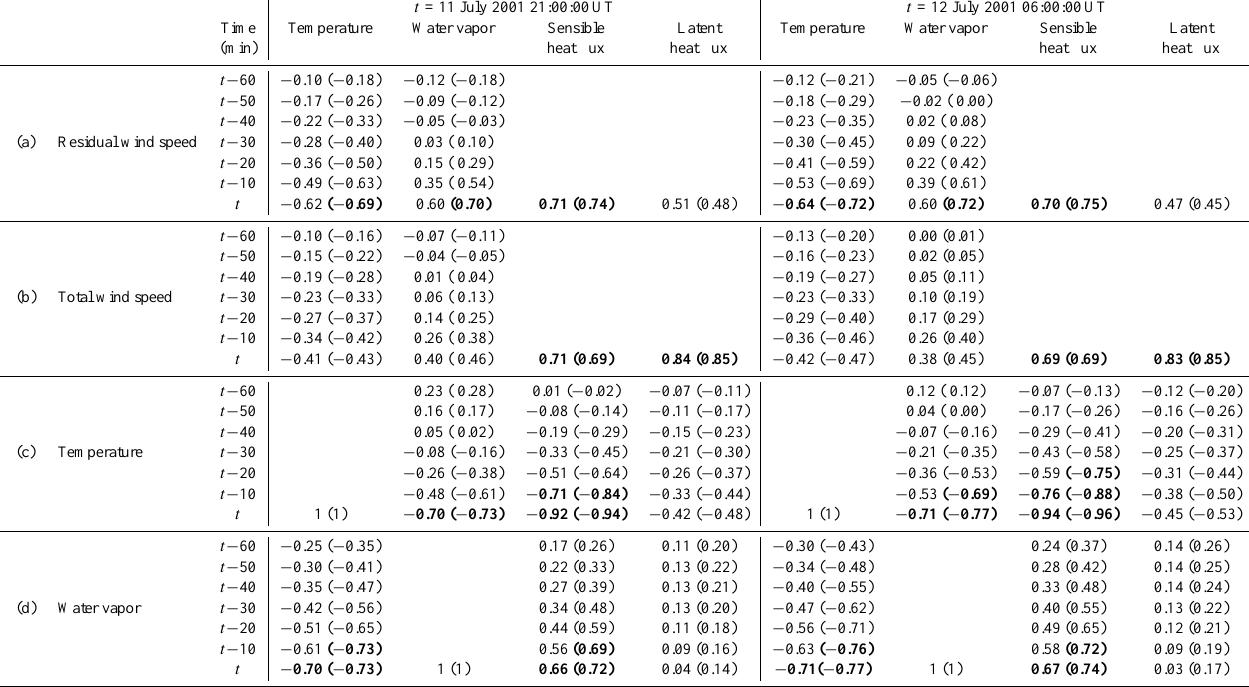
Table 2. Lagged spatial correlation coefficients of surface quantities in simulation S ◦ . Correlation coefficients with an absolute value ≥ 0 . 66 are highlighted in bold. Correlation coefficients in parentheses were calculated from data after filtering with a circular low-pass filter with a diameter of 4500m. Autocorrelation coefficients for lags < 0 were not calculated. Correlation coefficients between the surface heat fluxes and surface wind speeds were not computed for lags < 0, because surface heat fluxes are calculated from the simultaneous (total) wind speed at the lowest model